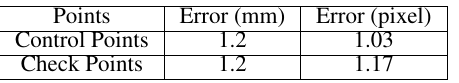
Table 2. Error magnitude in